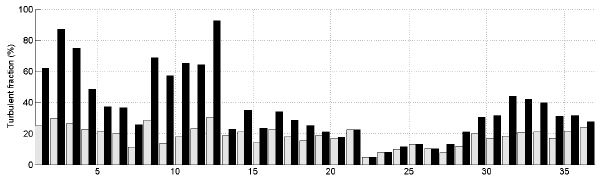
Fig. 4. Fraction of depth of all the detected turbulent overturns (i.e. total depth/troposphere depth) for each balloon flight for a dry tro- posphere (gray line) and after including the saturation effects (black